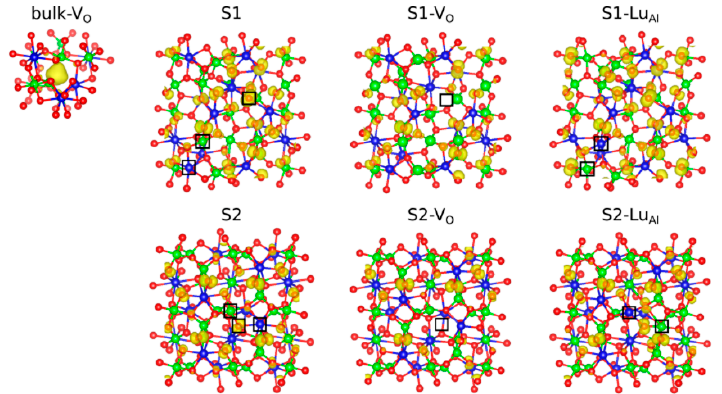
Figure 5. Projected charge density of the defect states in the band gap for the bulk and surfaces. The isovalue of the isosurfaces (yellow color) is set to 0.01 electrons/bohr3. The locations of the defect sites on the surface are marked by black